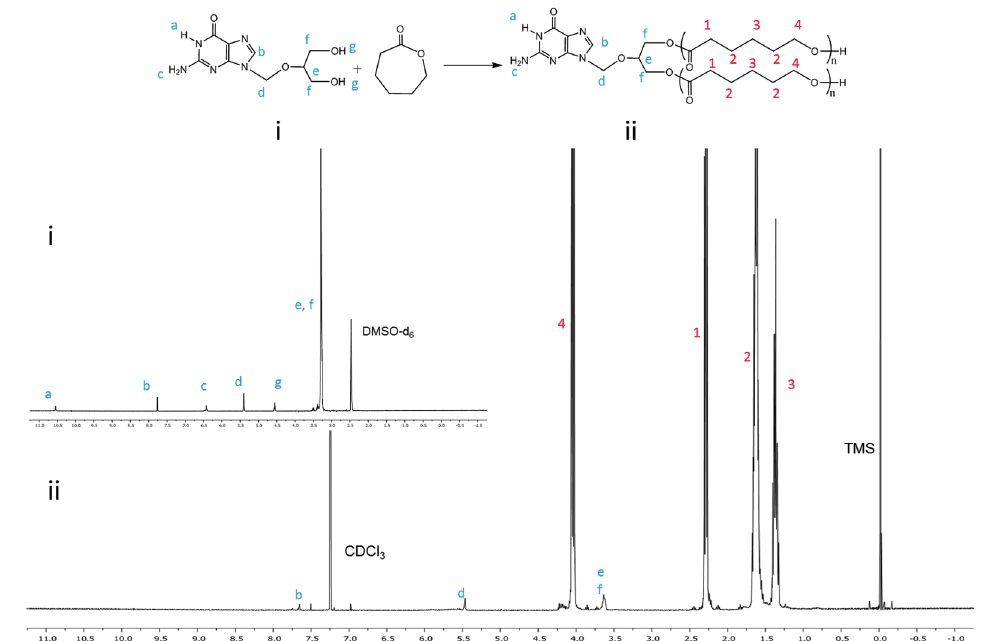
Figure 1. 1 H-NMR spectra of ( i ) GCV and ( ii ) GCV-PCL.